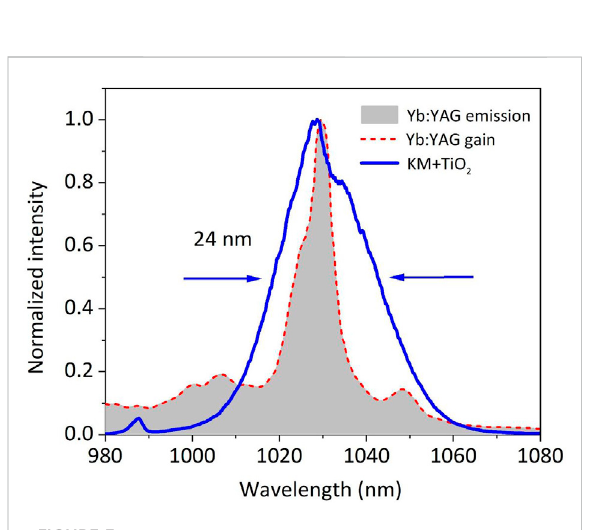
FIGURE 3 Comparison of the output spectrum, the emission spectrum and the gain spectrum of